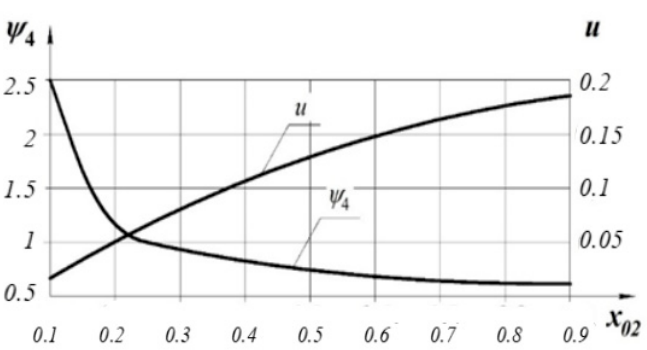
Figure 8. The degree of vapor overproduction and injection coefficient from mass vapor content in